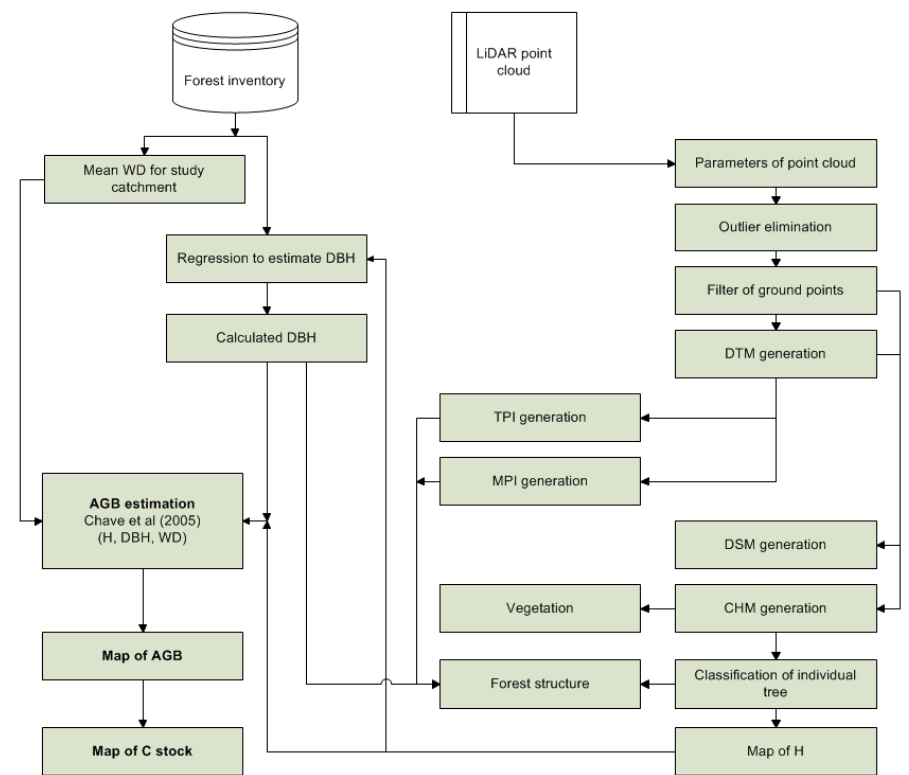
Figure 3. Processing chain to calculate above ground biomass (AGB) and C stock based on LiDAR point cloud data (WD = Wood Density, H = Tree Height, DBH = Diameter at Breast Height, DTM = Digital Terrain Model, DSM = Digital Surface Model, CHM = Canopy Height Model, TPI= Topographic Position Index and MPI= Morphometric Protection Index).